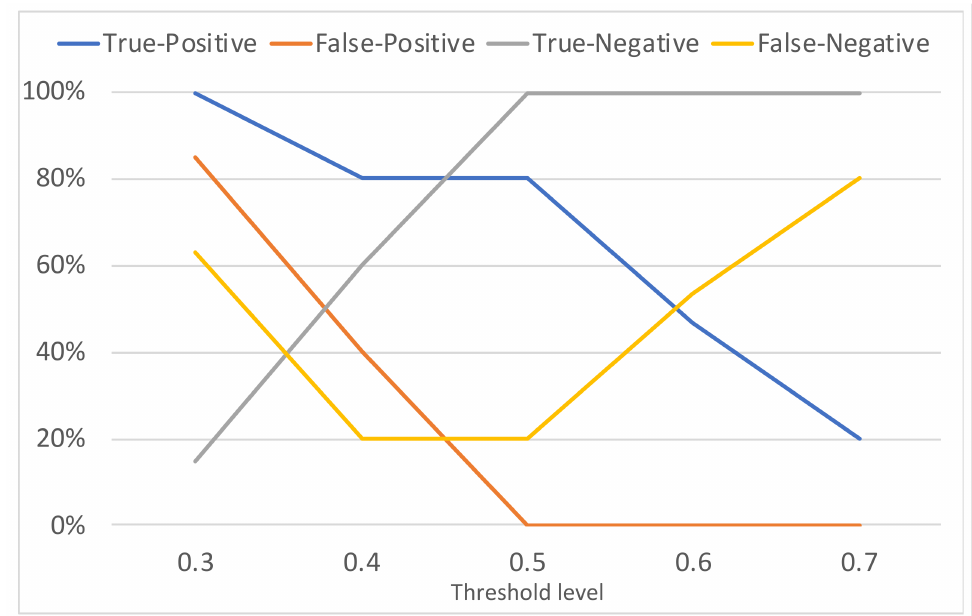
Figure 14. Performance of the triggering mechanism in attacks to an AIS/ECDIS system.